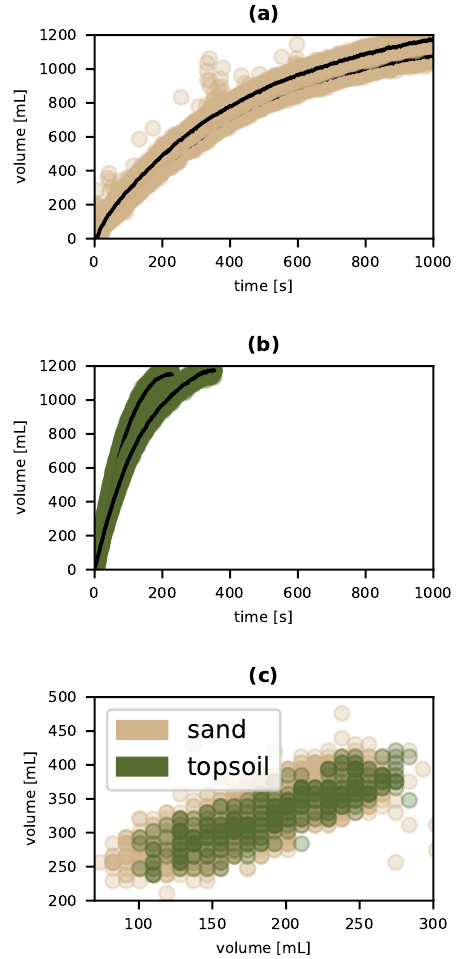
Figure 4. The movement of water through sand and soil. Volume through time of a 1200 mL sample of water passing through a vertical column of ( a ) sand and ( b ) topsoil at atmospheric pressure. Each panel shows two curves representing successive experiments that differ only in how much water is already retained by the column of material ( ≈ 100 mL for the second run with either material). The implied dynamical symmetries ( c ) for sand (tan) and for topsoil (green) are